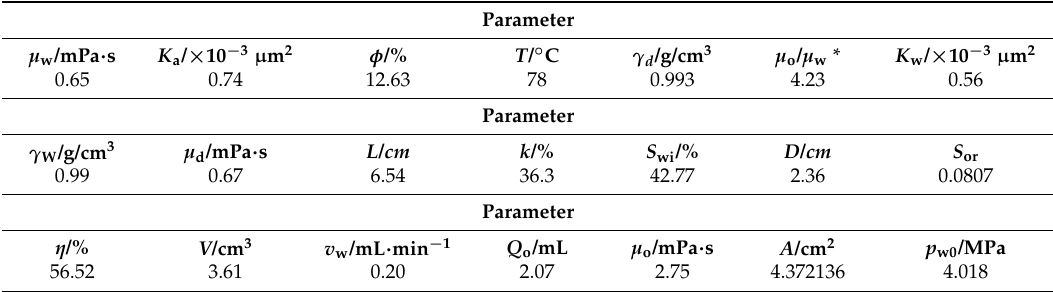
Table 3. Core physical property parameters and experimental conditions.